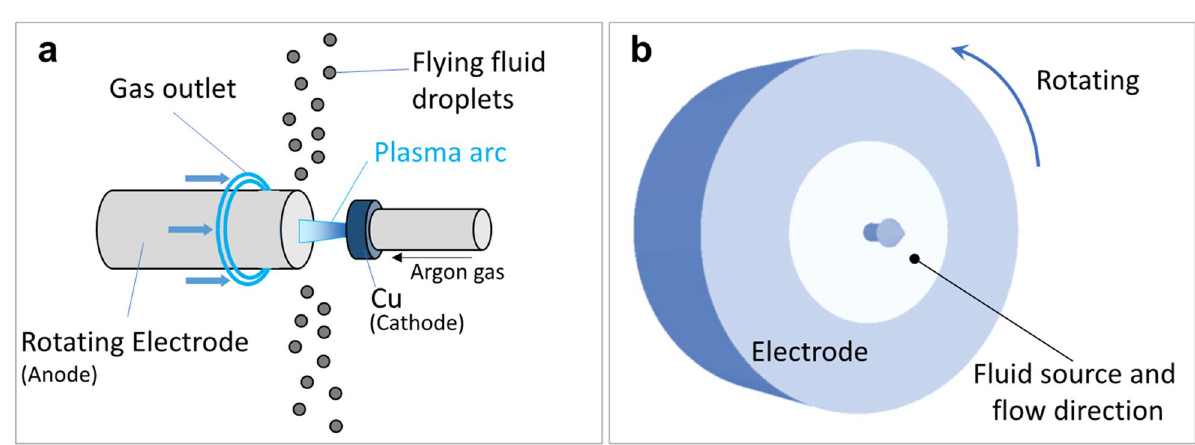
Figure 13. ( a – c ) CtFD-simulated PREP process of SUS316 and ( d , e ) corresponding PSD under the operating conditions corresponding to the cases in Fig. 3 with currents of ( a ) 50, ( b ) 70, and ( c ) 90 A. The melting rates determined by the currents were set according to the experimental ones shown in Fig. 4b.